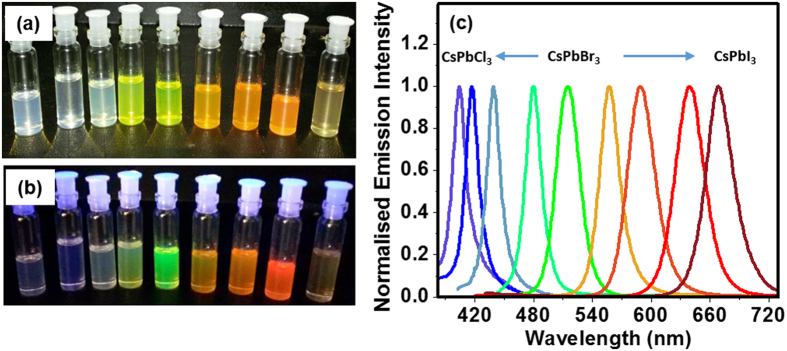
Series of CsPbX3 solutions collected at different stages of the anion exchange of CsPbBr3 nanocubes (~34 nm) with PbCl2 and PbI2 in toluene at room temperature and open atmosphere under day light (a) and ultraviolet light (b), and their PL spectra (c).